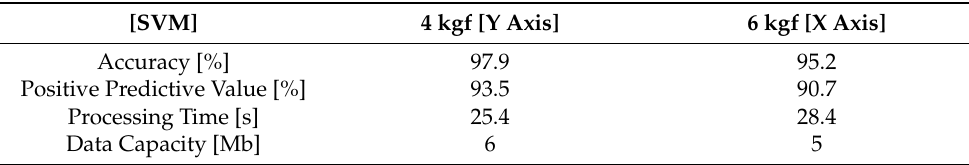
Figure 9. Volume comparison of normal and abnormal condition data: ( a ) Operating tension of 4 kgf; ( b ) Operating tension of 6 kgf. Table 19. Nip force non-uniformity fault diagnosis based on smart data.